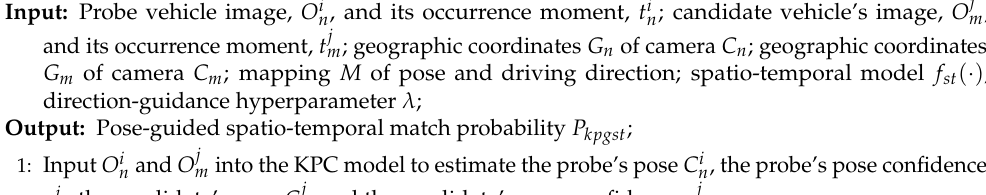
Algorithm 1 Pose-Guided Spatio-Temporal